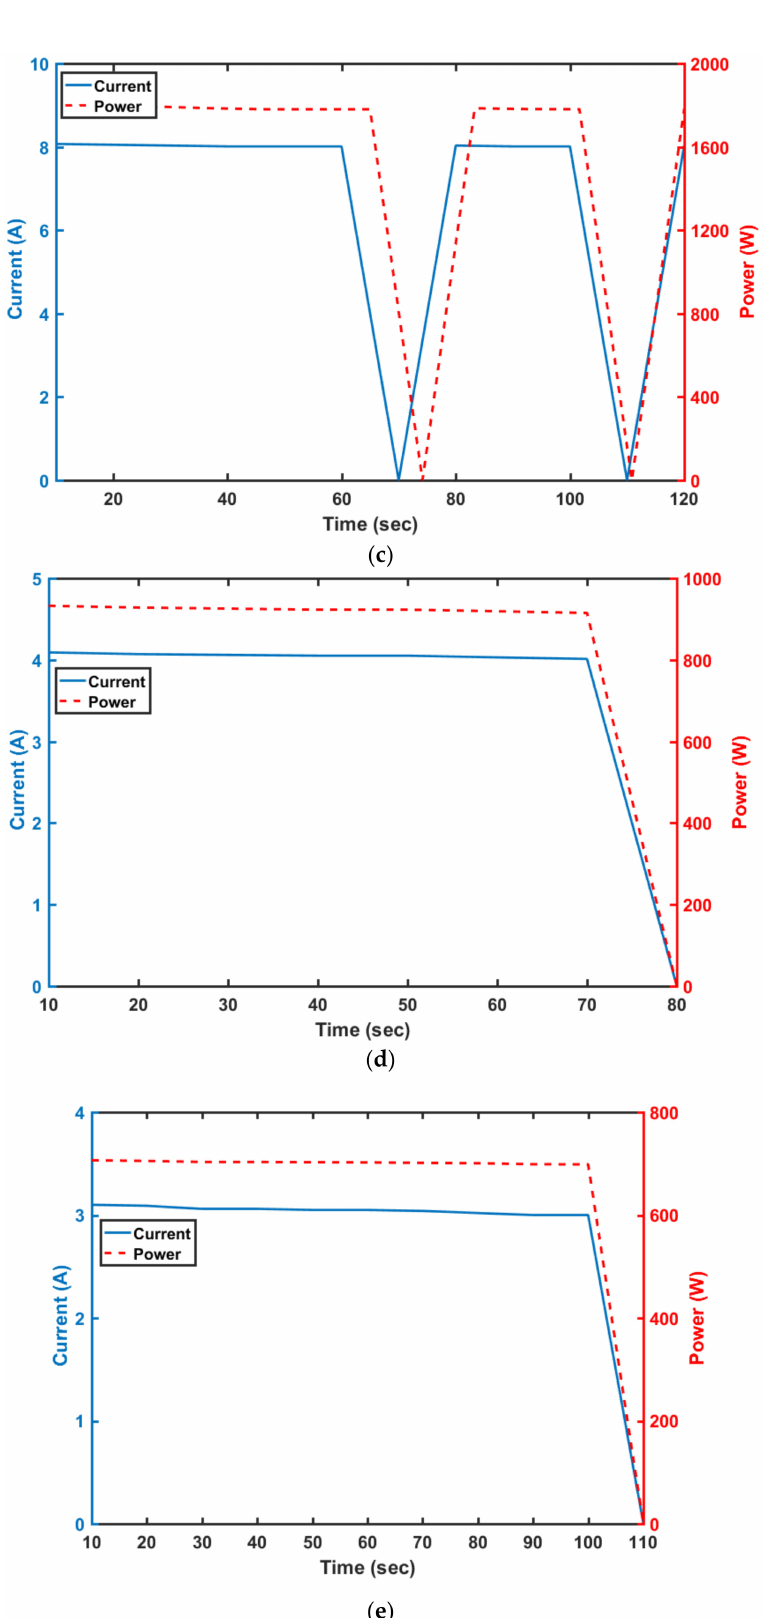
Figure 6. Experimental results for a ( a ) 55-W standing fan, ( b ) 105-W TV, ( c ) 1800-W garment steamer, ( d ) 1000-W iron, and ( e ) 800-W